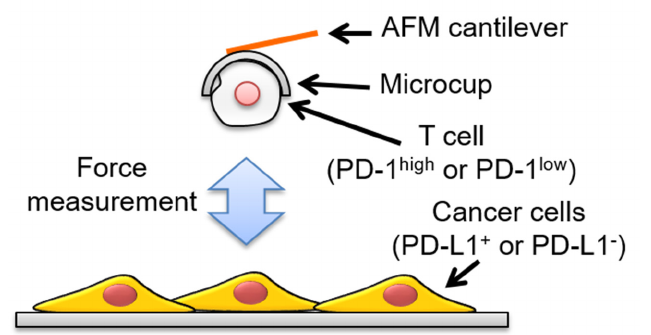
Figure 2. Experimental setup used in this study. A T cell was picked up using the cup-chip, used to approach a cancer cell, and the intercellular adhesion force was measured.